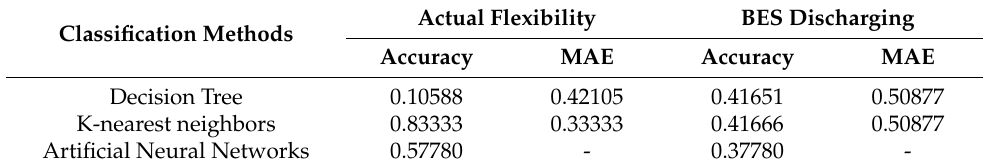
Table 6. Performance results from the classification methods.